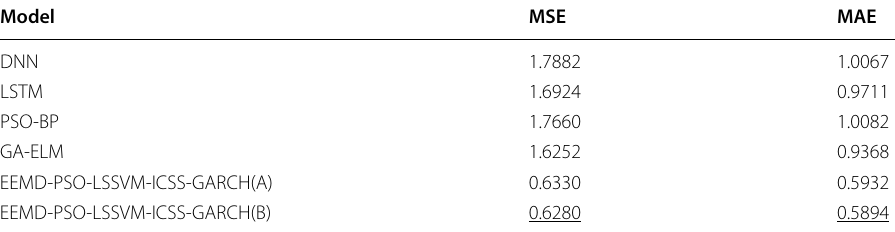
Table 8 1‑Day ahead forecasting results for daily log‑returns of the AIRO index of different benchmarking models